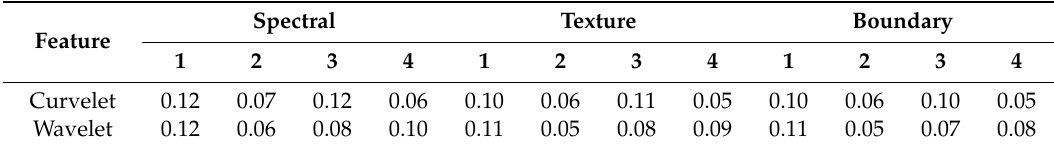
Figure 6. Changes of features’ weight values for all the classes by using curvelet and wavelet feature sets: ( a1 )–( a2 ) Feature 1, ( b1 )–( b2 ) feature 2, ( c1 )–( c2 ) feature 3. Table 3. Approximate feature weight values for a simulated SAR